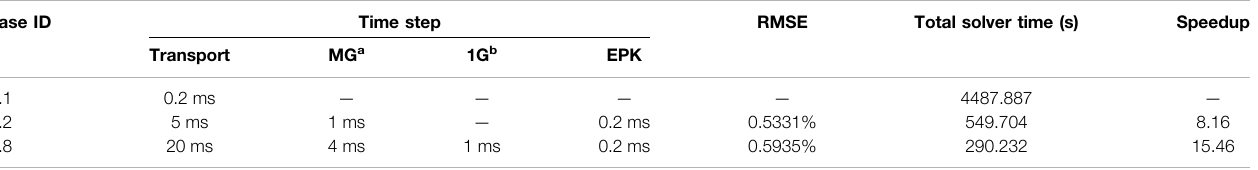
TABLE 5 | Overall acceleration performance for the AML-PCQM scheme in Problem 2 case ID Time